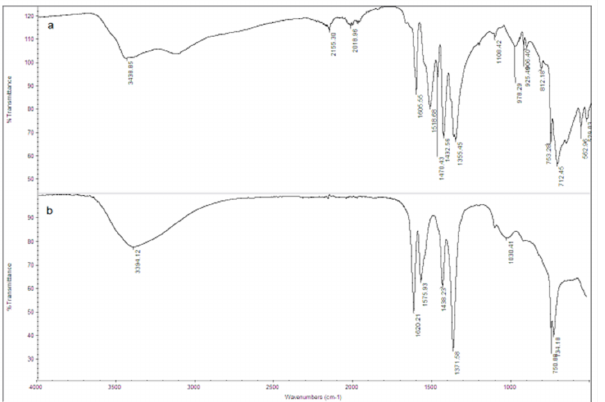
Figure 10. FT-IR spectra of Zn 3 (BTC) 2 : As prepared (spectrum a) and after OFL adsorption in tap water (spectrum